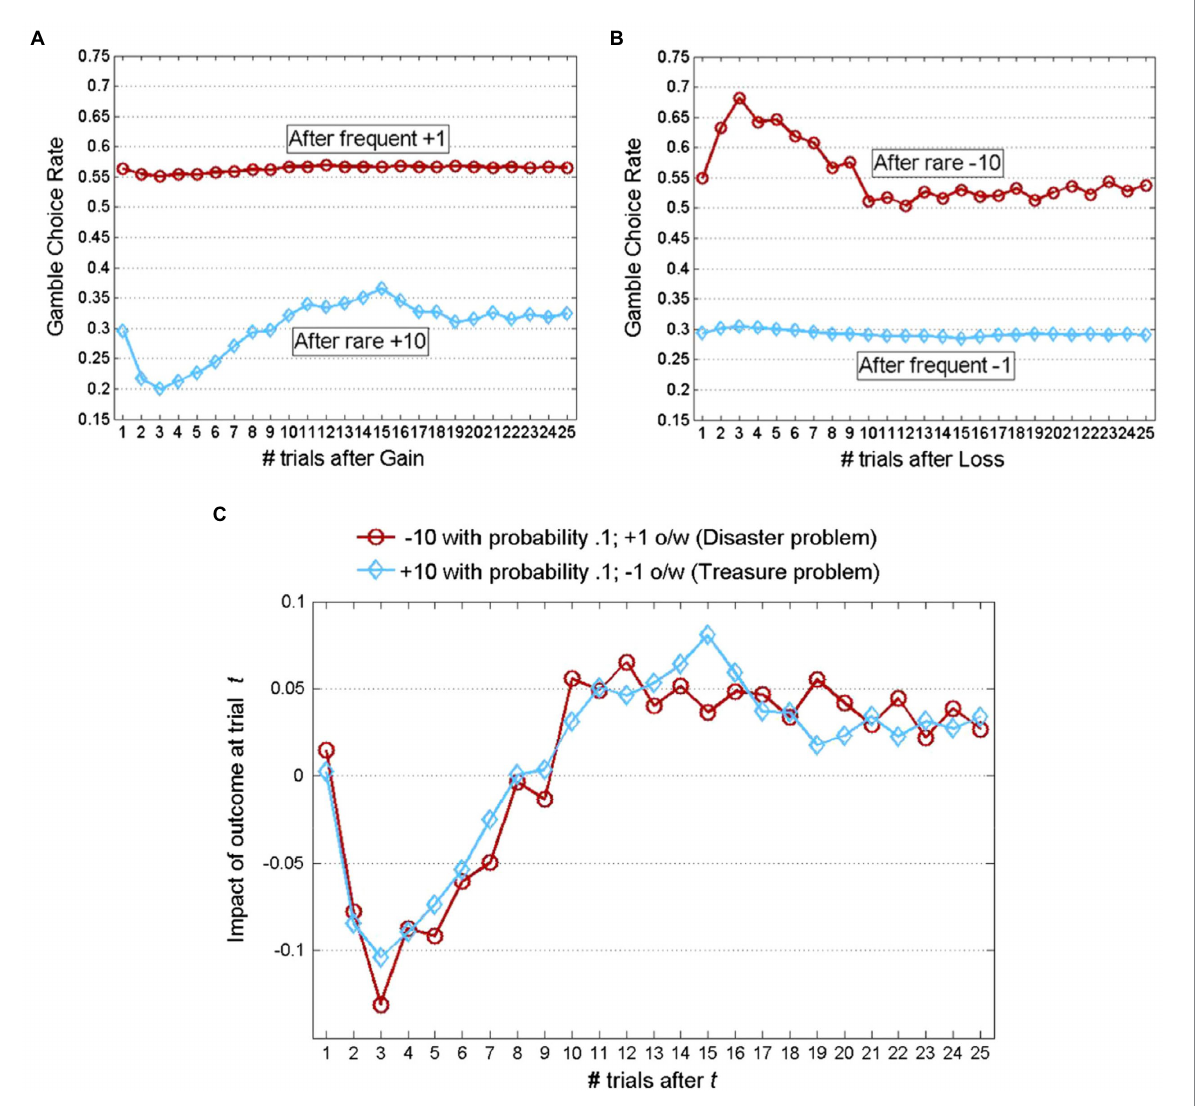
FIGURE 5 Demonstration of the wavy recency effect (adapted from Plonsky and Erev, 2017). Participants selected repeatedly for 100 trials between two unmarked buttons and received feedback concerning the payoff from both the chosen and the forgone option following each trial. One option generated a payoff of 0 with certainty while the other was a risky gamble detailed in the legend. (A) Exhibits the choice rates of the gamble contingent on the gamble providing a gain at trial t; (B) exhibits the choice rates of the gamble contingent on the gamble providing a loss at trial t; and (C) presents the difference between the corresponding plots in (A,B) . Thus, the wavy curves in (C) reflect the impact of an outcome generated by the gamble at trial t on its choice rate in subsequent trials. Positive values (on the Y-axis) imply “positive recency” and negative values imply “negative recency.” Data is averaged across 48 participants from Nevo and Erev (2012) and 80 participants from Teoderescu et al.